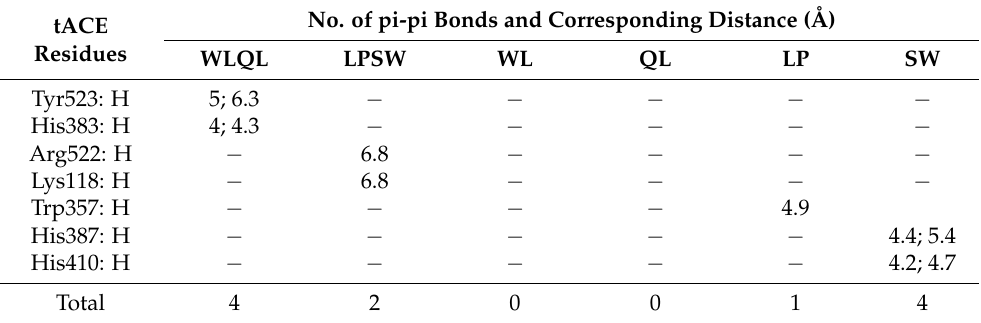
Table 5. Pi-pi bonds observed between the top-ranked docked poses of peptides and tACE a